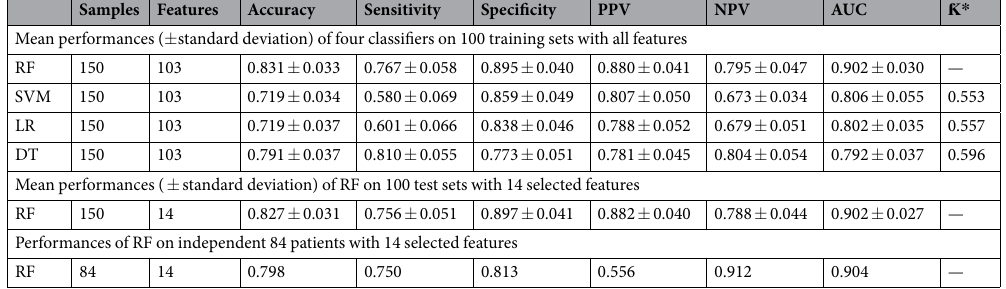
Table 2. Validated predictive performance of classifiers. PPV, Positive Predictive Value; NPV, Negative Predictive Value; AUC, Area Under Curve; SVM, Support. Vector Machine; LR, Logistic Regression; DT, Decision Tree; RF, Random Forest.